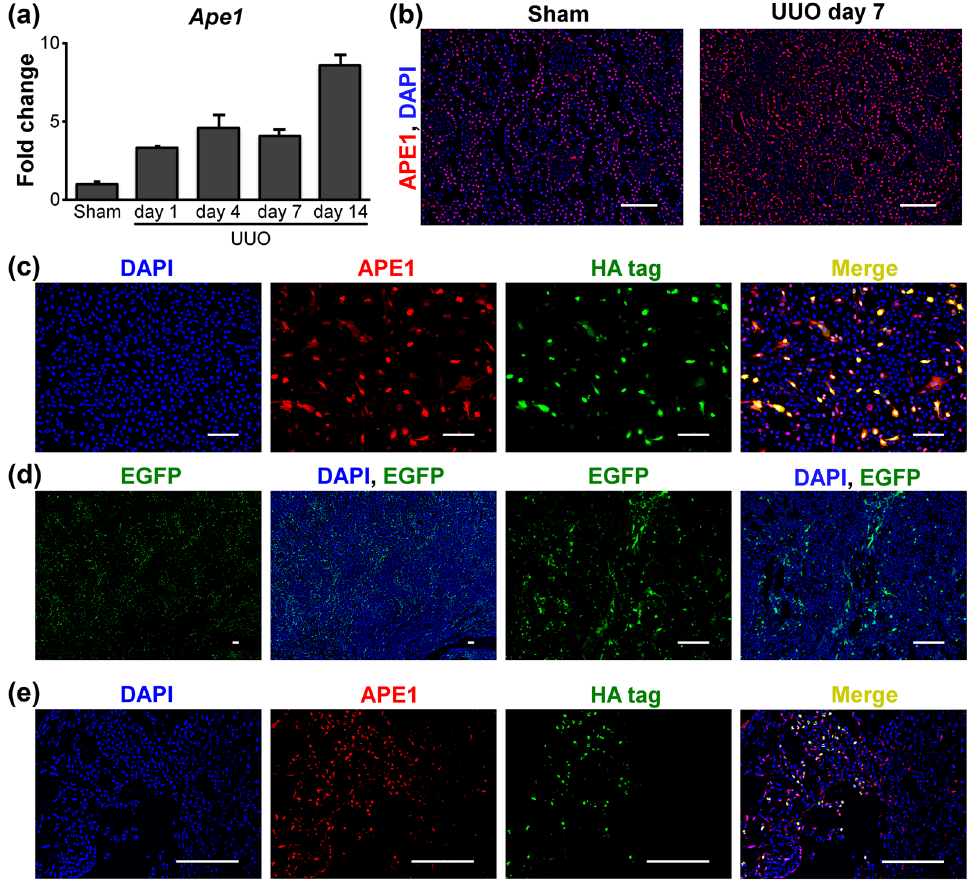
Figure 1. APE1 expression in the kidney of sham-operated and unilateral obstructed ureter (UUO) mice and functional analysis of plasmid vectors in vitro and in vivo . ( a ) APE1 mRNA expression in the control and ureter- obstructed kidney (n = 3/group). Data are presented as the mean ± SEM. ( b ) Immunohistological expression of APE1 in the control and UUO kidney. APE1 exhibited nuclear localization in essentially all cells of sham kidneys, whereas in UUO kidneys, APE1 staining was mainly observed in tubular epithelial cells and interstitial cells. ( c ) Transgene expression of pCAG-APE1 vector in BHK-21 cells. ( d ) EGFP expression in the pCAG- EGFP-injected interstitium 4 days after UUO. ( e ) APE1 expression in the pCAG-APE1-injected interstitium 4 days after UUO. Scale bars: 100 μ